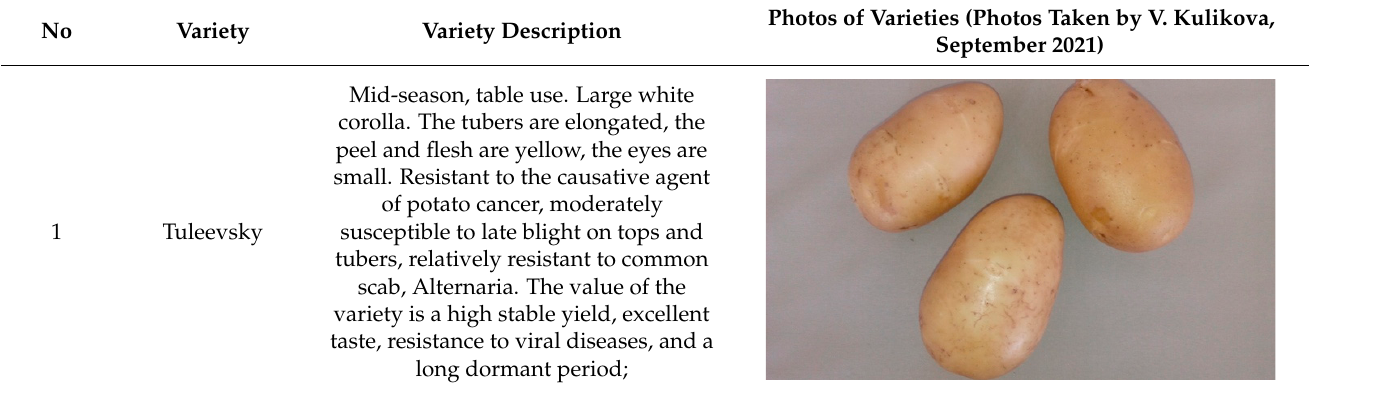
Table 1. The description of potato varieties from Siberian Federal Scientific Centre of Agrobiotechnol- ogy.